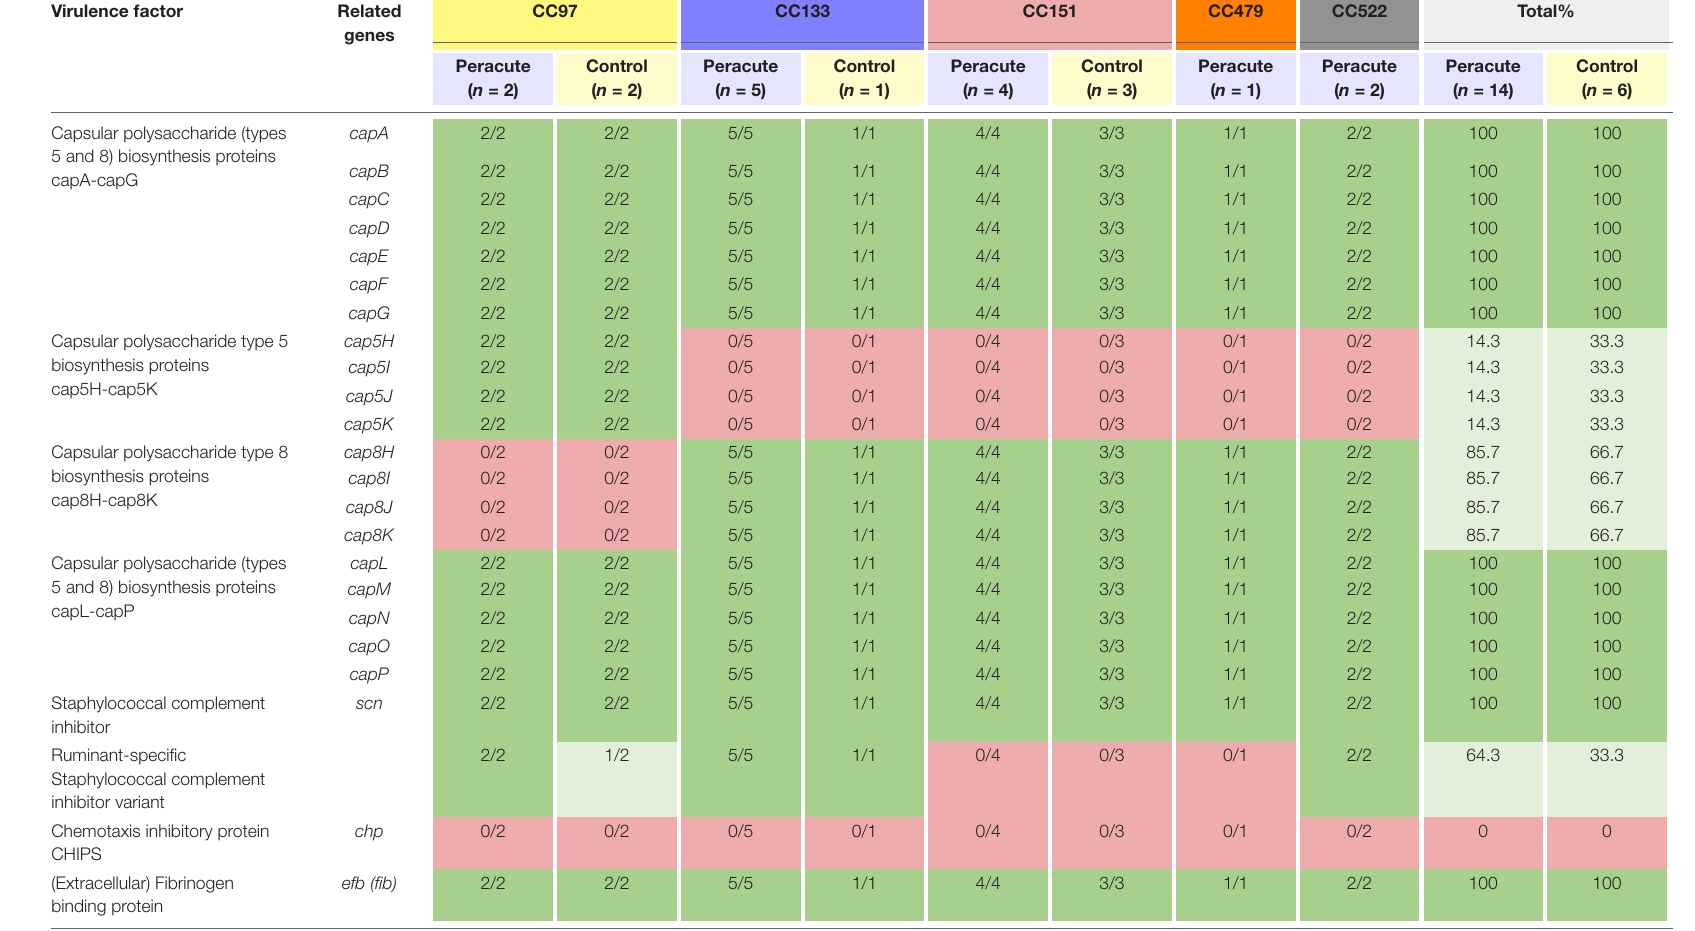
TABLE 5 | Distribution of immune evasion genes in 20 Staphylococcus aureus isolates from bovine mastitis milk samples classified by clonal complex (CC) and study group. Virulence